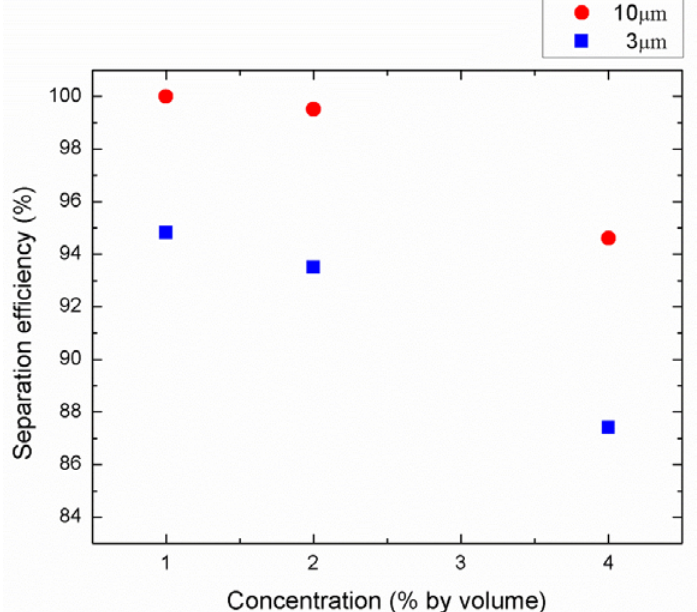
Figure 12. Separation efficiency as a function of particle concentration for 3 and 10 μ